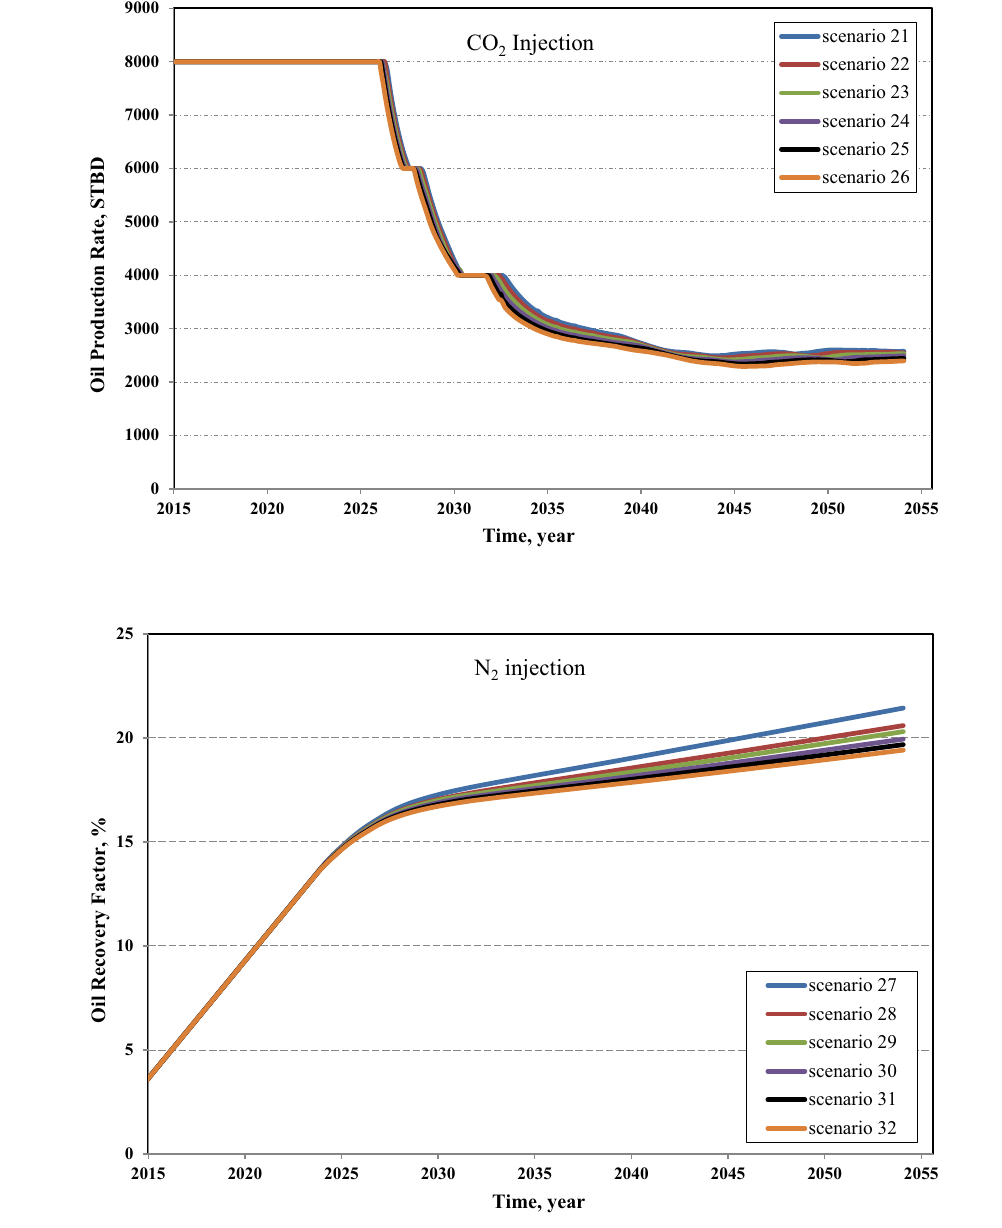
Fig. 10 Reservoir oil produc- tion rate for CO 2 injection into different reservoir layers